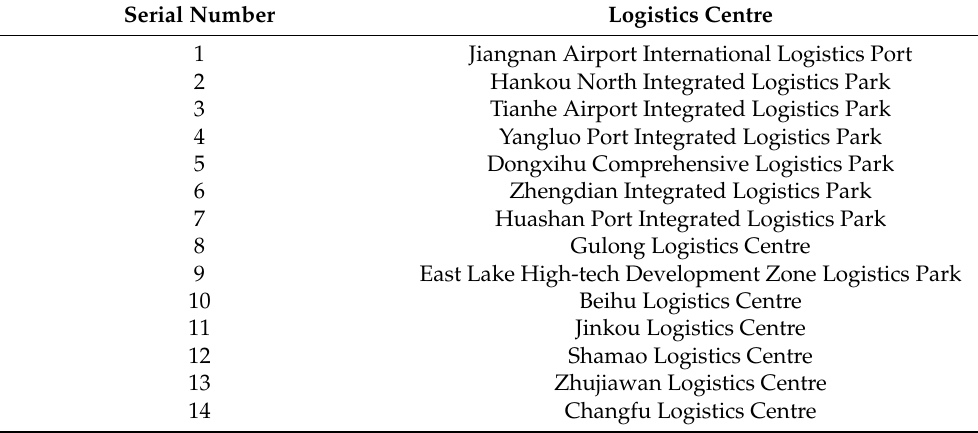
Figure 6. The distribution of logistics supply facilities in Wuhan. Table 3. The current logistics centres in